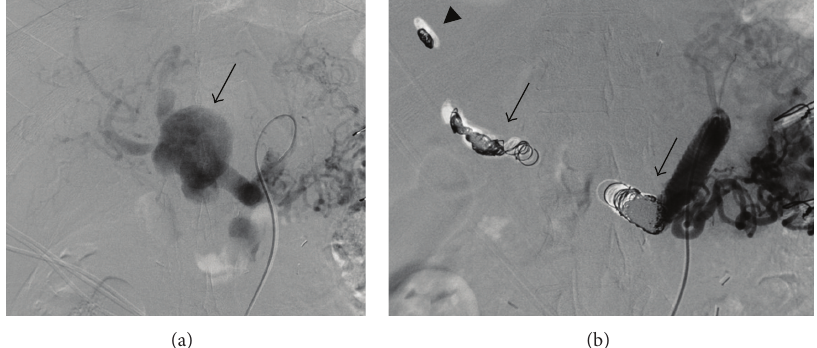
Figure 2: (a) Celiac angiography demonstrates a saccular aneurysm (arrow) 2 cm distal to the origin of the common hepatic artery (CHA). (b) Celiac angiography after embolization of the right hepatic artery and CHA (arrow) shows the occluded aneurysm. Incidentally migrated coils (arrowhead) are seen in the distal part of the